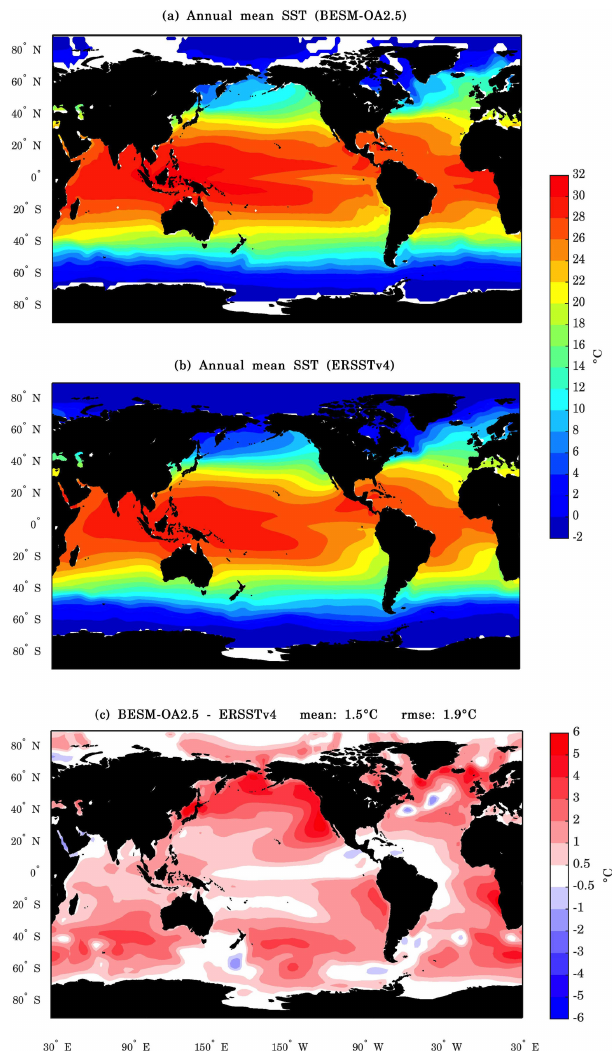
Figure 11. (a) Mean SSTs along the Equator in the Pacific Ocean and the annual cycle of the equatorial Pacific SST anomalies for (b) BESM-OA2.5 and (c) ERSSTv4. The equatorial region is defined by averaging over 2 ◦ S–2 ◦ N. The BESM-OA2.5 and ERSSTv4 data were averaged over the period 1971–2000. In (a) , the grey shading represents the spread of 11 CMIP5 models, which were also averaged over the period 1971–2000. Units are in degrees